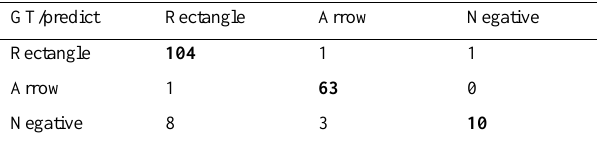
Table 2. Confusion matrix for the first level of hierarchy